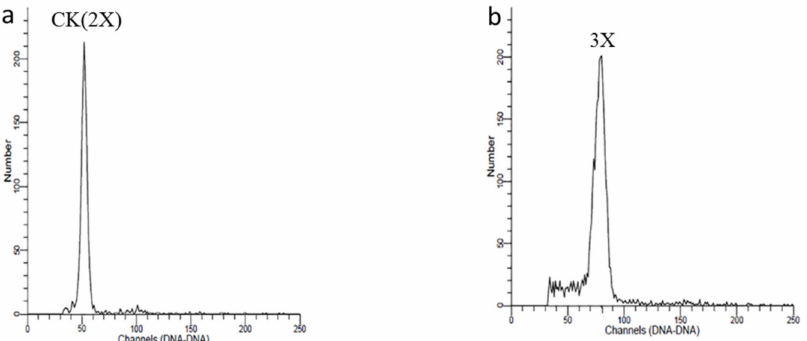
Figure 7. Ploidy level detection of offspring by flow cytometry. ( a ) CK represent untreated diploid offspring ( 2n = 2x = 24); ( b ) triploid offspring ( 2n = 3x =